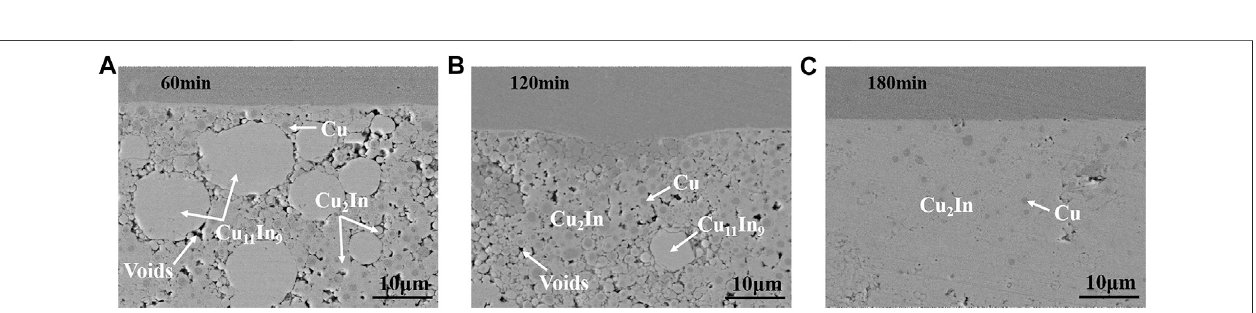
Frontiers in Materials |